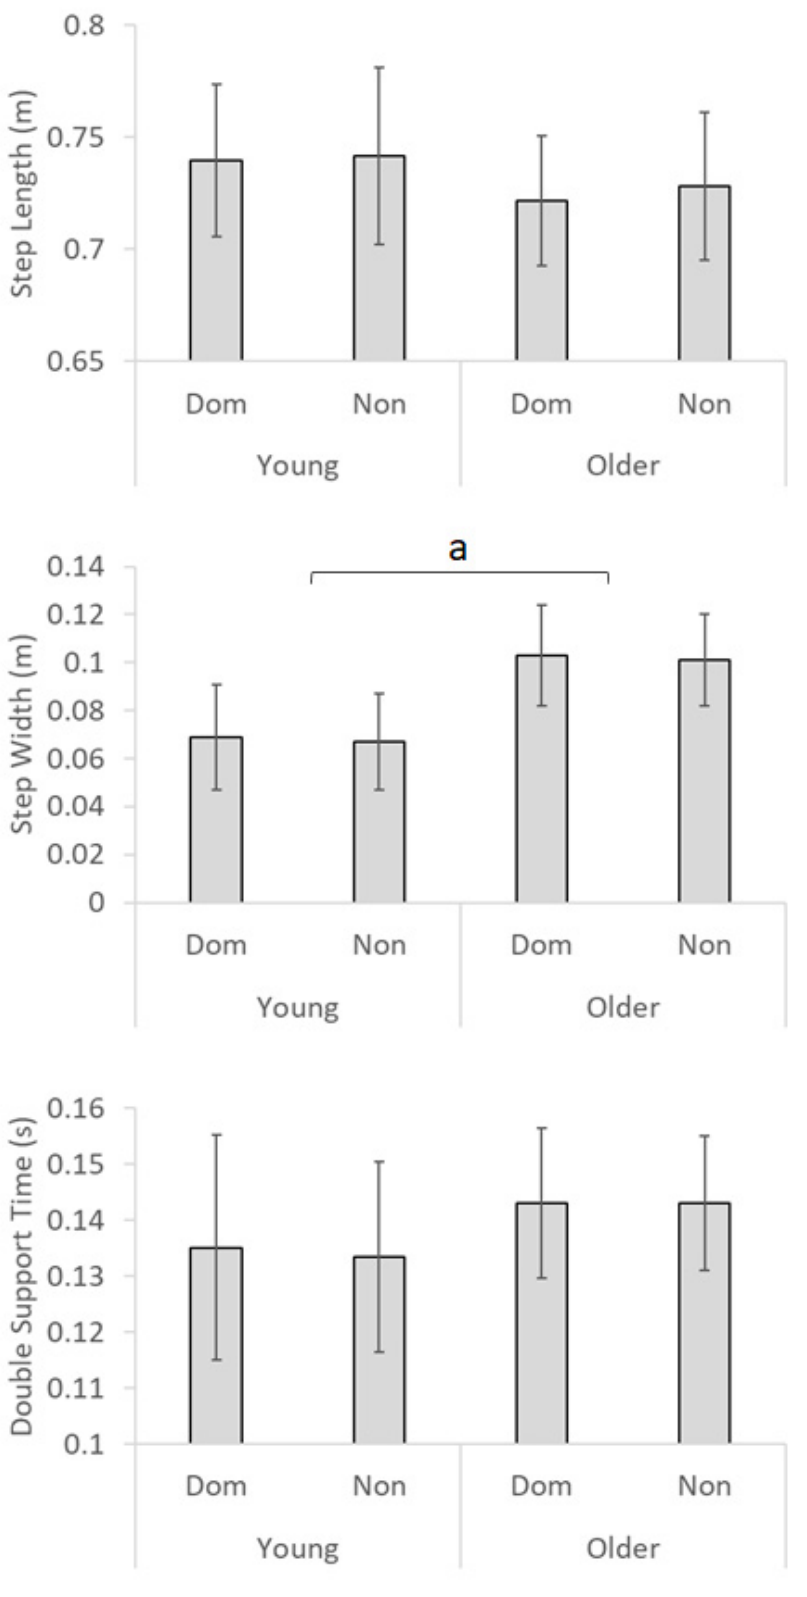
Figure 5. Spatio-temporal parameters. ( top ) step length; ( middle ) step width; ( bottom ) double support time, mean / SD; Dom / Non = dominant / non-dominant limb’s values; a = significant ageing e ff ect, l = significant limb e ff